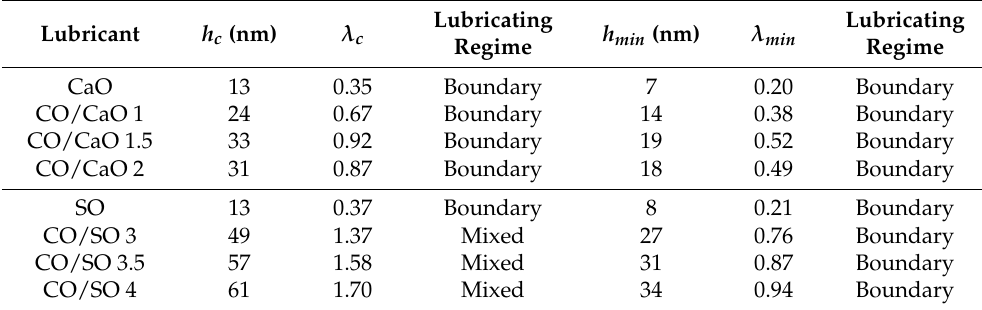
Lubricating Lubricating h min (nm) λ min Regime